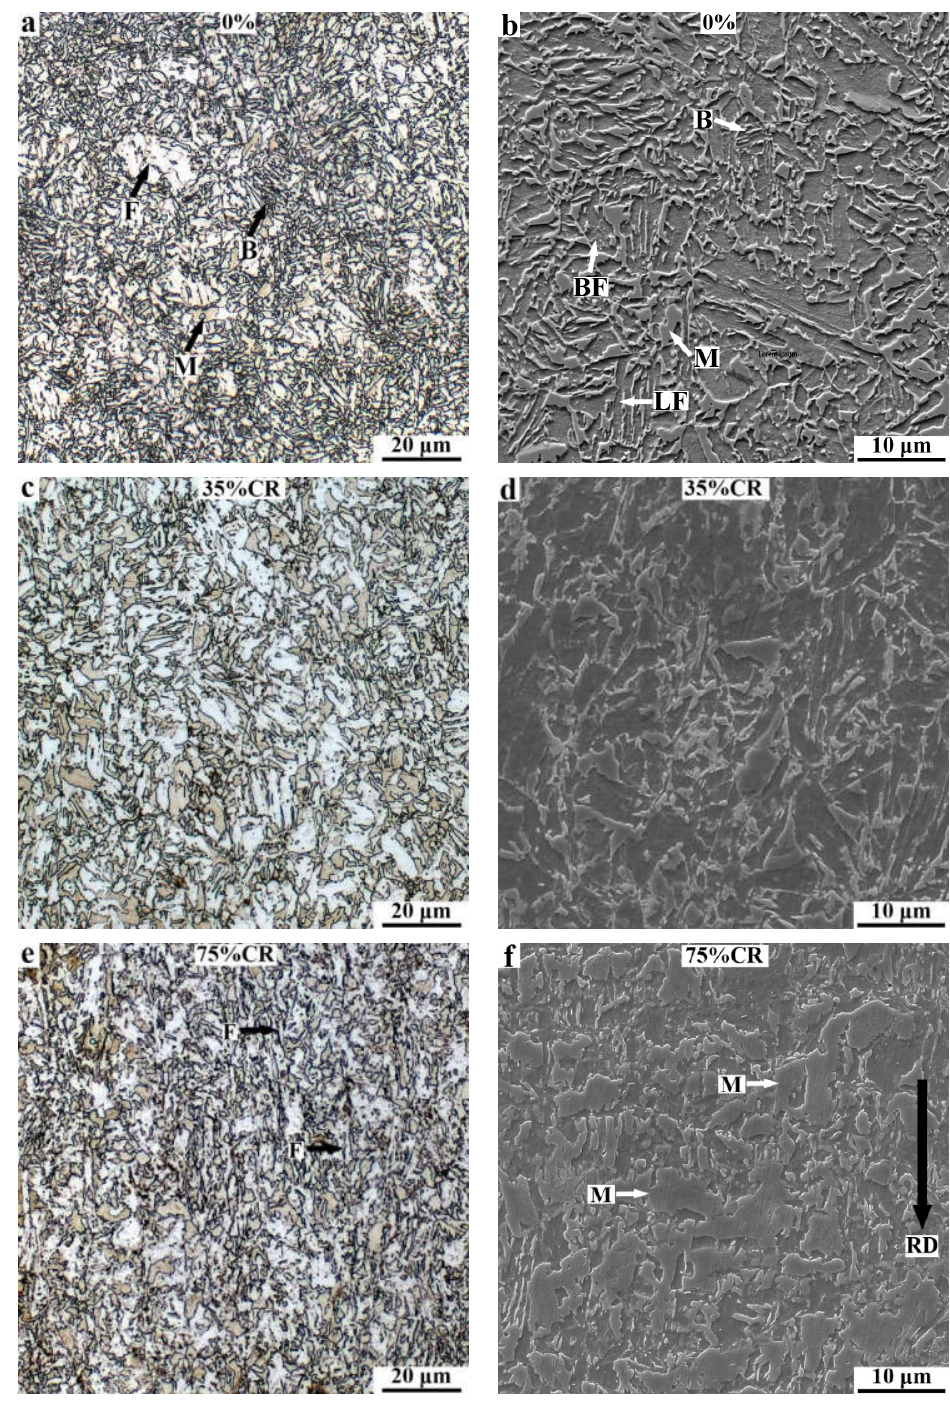
Figure 2. OM and SEM micrographs of ( a , b ) initial HR, ( c , d ) 35%, and ( e , f ) 75% cold reduction 0.2C−1.7Si−1.9Mn wt% sheets. B, F, and M refer to bainite, ferrite, and martensite, respectively. The rolling direction (RD) is shown in ( f ).